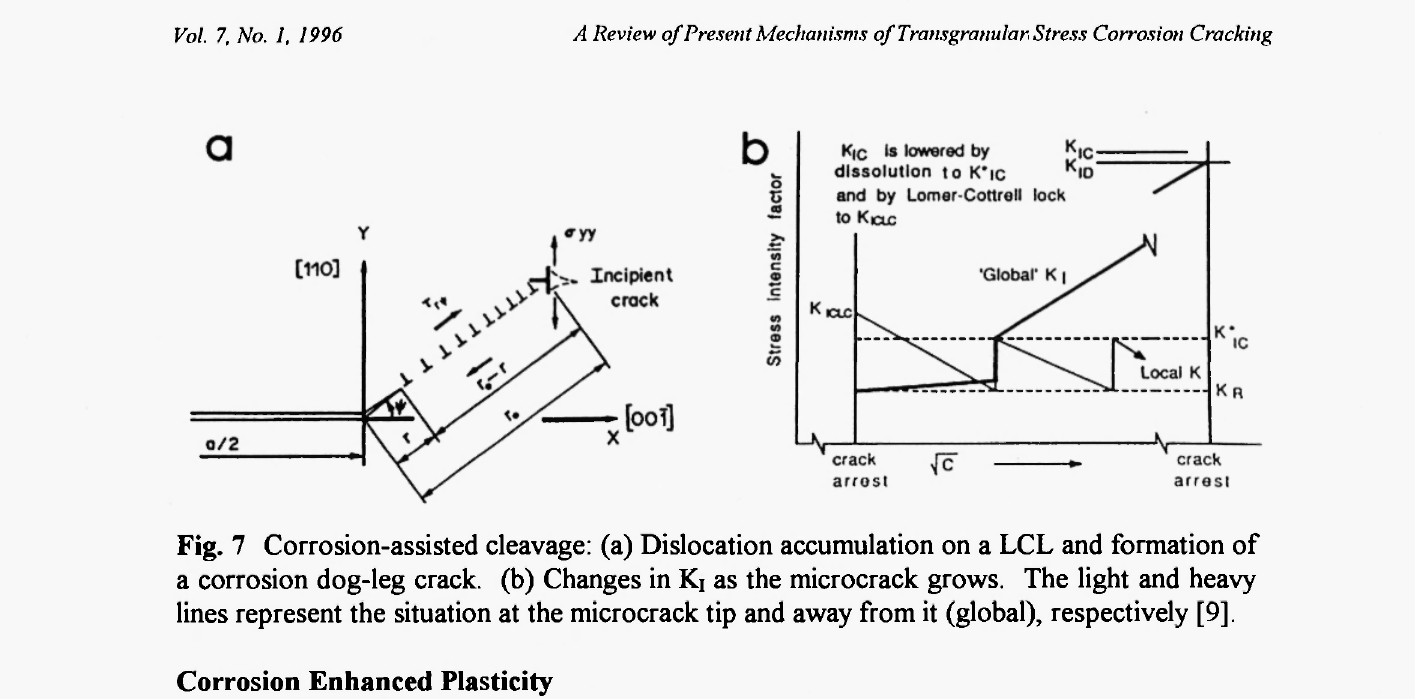
Fig. 7 Corrosion-assisted cleavage: (a) Dislocation accumulation on a LCL and formation of a corrosion dog-leg crack, (b) Changes in Ki as the microcrack grows. The light and heavy lines represent the situation at the microcrack tip and away from it (global), respectively